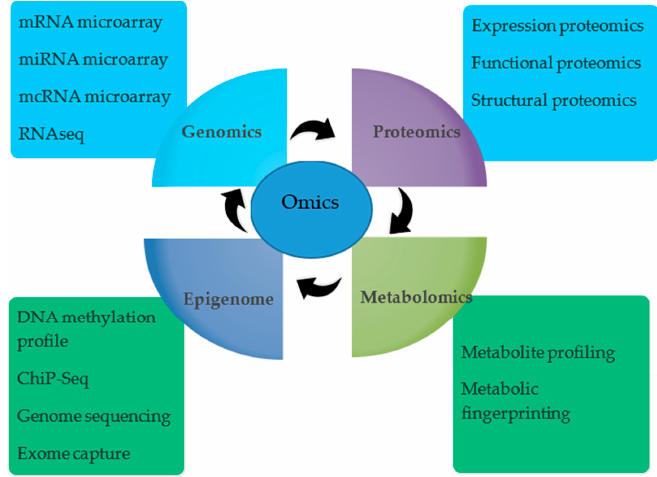
Figure 1. Key branches of omics and their major components being used at molecular and genetic level in different integrated approaches in wheat.